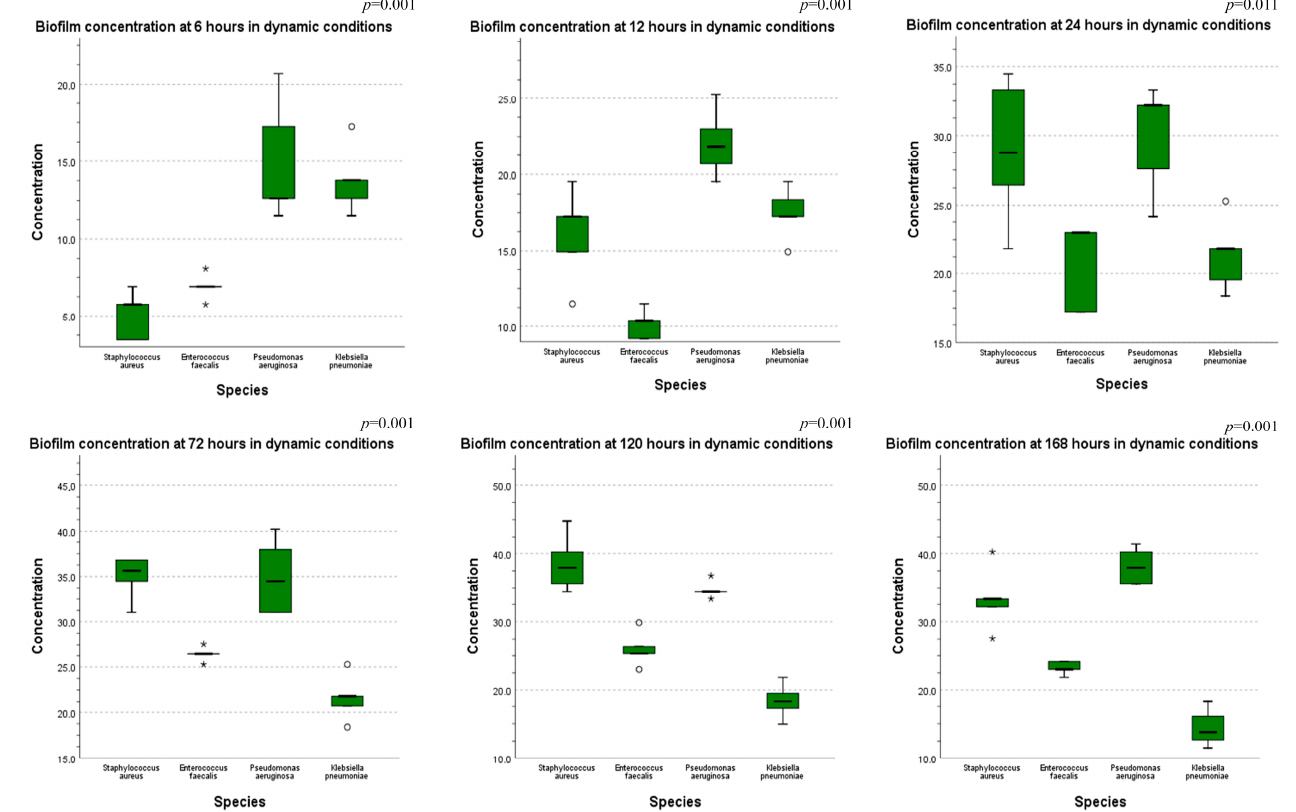
Figure 10. Comparison of biofilm concentration across all species tested in dynamic conditions, at 6 h-12 h-24 h-72 h-120 h-168 h (ANOVA test performed— p -values